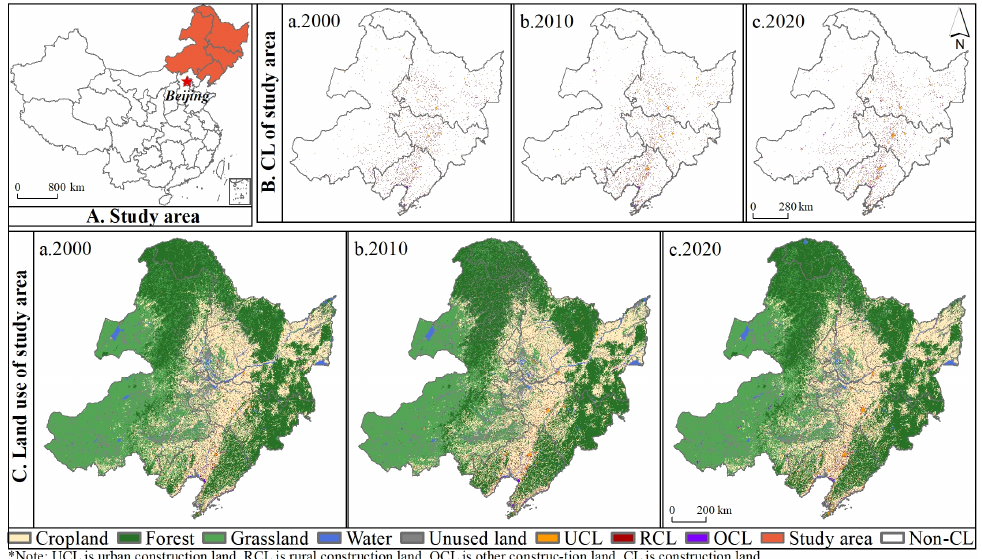
Figure 1. Geographical location of the study area in northeast China. ( a ) 2000; ( b ) 2010; ( c ) 2020.